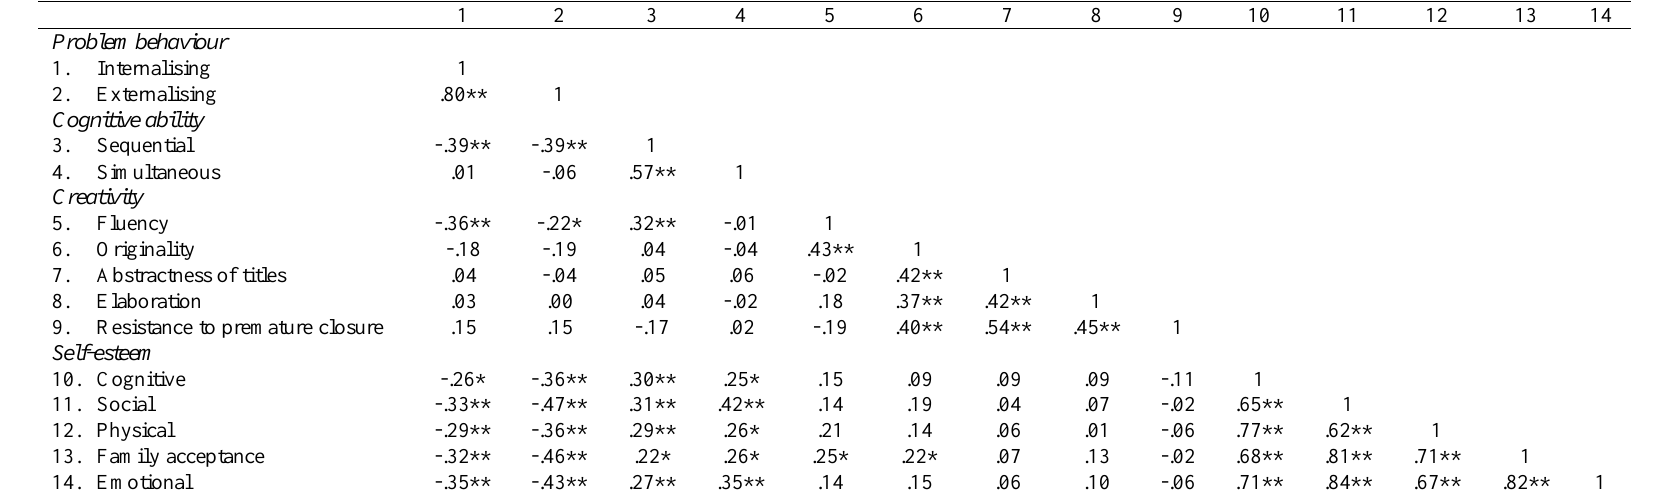
Table 1 Correlations between measures of cognitive ability, creativity, self-esteem and problem behaviour ( N = 203)